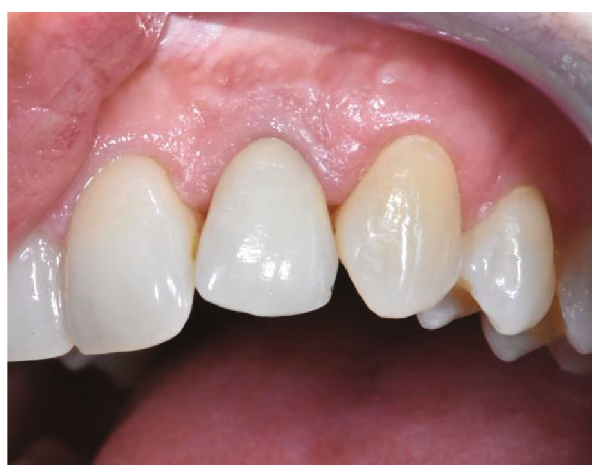
Figure 4: Tissue regeneration.